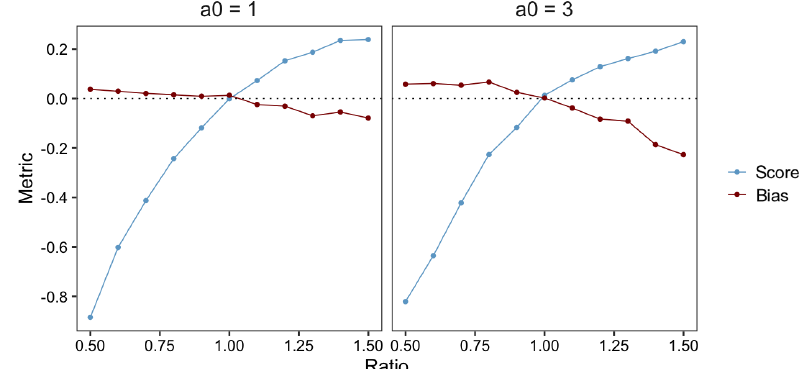
Figure 6. Estimated β -score and β -bias of FTE histograms constructed with τ = 1 for verification correlation length a 0 ∈ { 1 , 3 } and ensemble range a M varying from 0 . 5 a 0 to 1 . 5 a 0